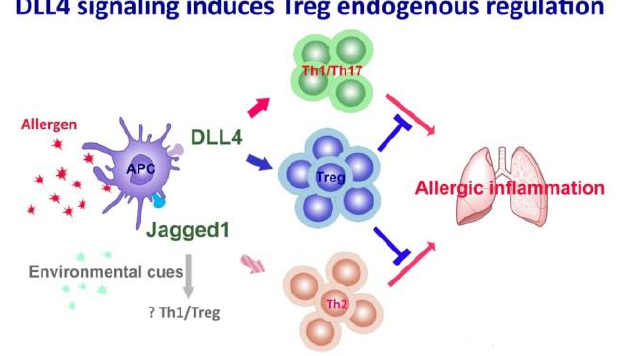
Figure 1. Delta-like ligand 4 (DLL4) and Jagged1 exert different effects on Th subsets differentiation. Whilst Jagged1 promotes Th2-mediated allergic inflammation in the lung, DLL4 signaling induces Tregs as the endogenous regulatory pathway, contributing to resolution of the allergic inflammation.